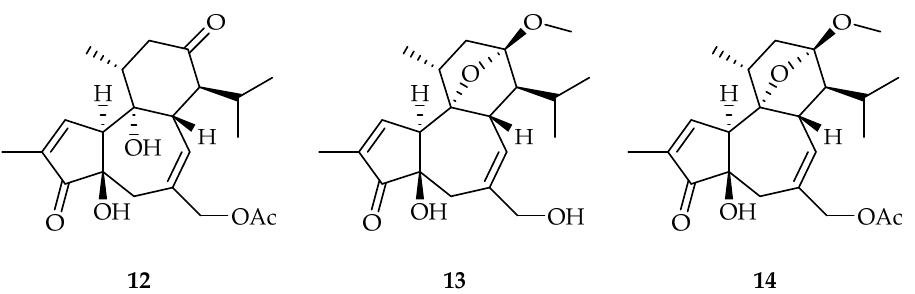
Figure 6. Structures of Langduin A6 12 [12], fischerianin A 13 [13], and fischerianin B 14 [13]. From the dry roots of Euphorbia fischeriana Steud were also isolated two new daphnane- type diterpenoids fischerianin A 13 and fischerianin B 14 [13]. Their structures, including the absolute stereochemistry, were determined by HRESIMS, IR, 1D and 2D NMR, as well as by comparing their experimental and calculated CD spectra. Compounds 13 and 14 harbor a ketal group and a 9,13-oxide bridge in their C ring, which is rare in daphnane-type diterpenoids. They showed cytotoxic activity against human cancer cell lines A375 (human melanoma cancer), HepG2, HL-60 (human erythroleukemia), K562, and HeLa, with IC 50 values ranging from 5.31 to 21.46 µ M, using cisplatin as a positive control (Figure 6).